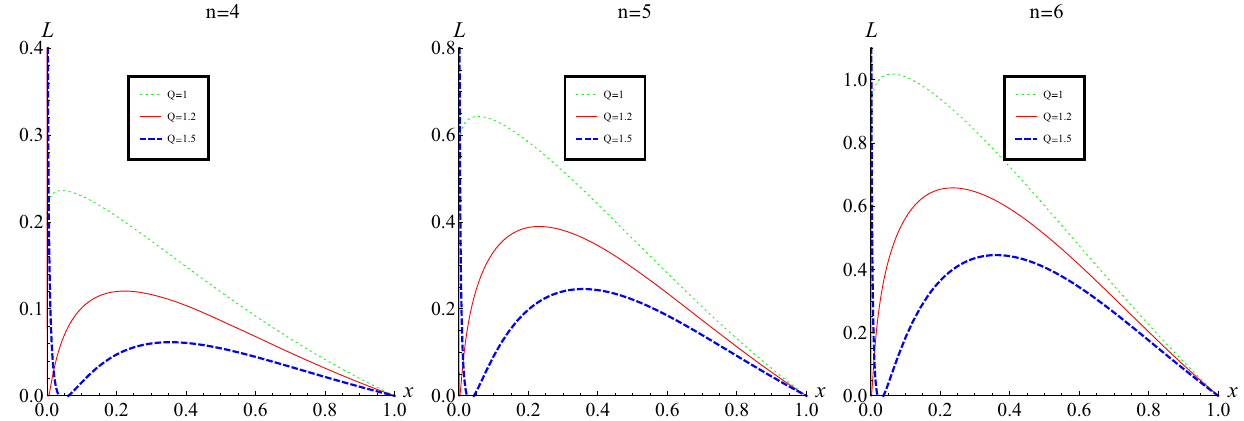
Fig. 4 L – x curves for the topological dilaton black hole in n -dimensional AdS spacetime as n = 4 , 5 , 6. In each diagram, the coupling coefficient α = 1 √ and the arbitrary constant b = 1 . 3